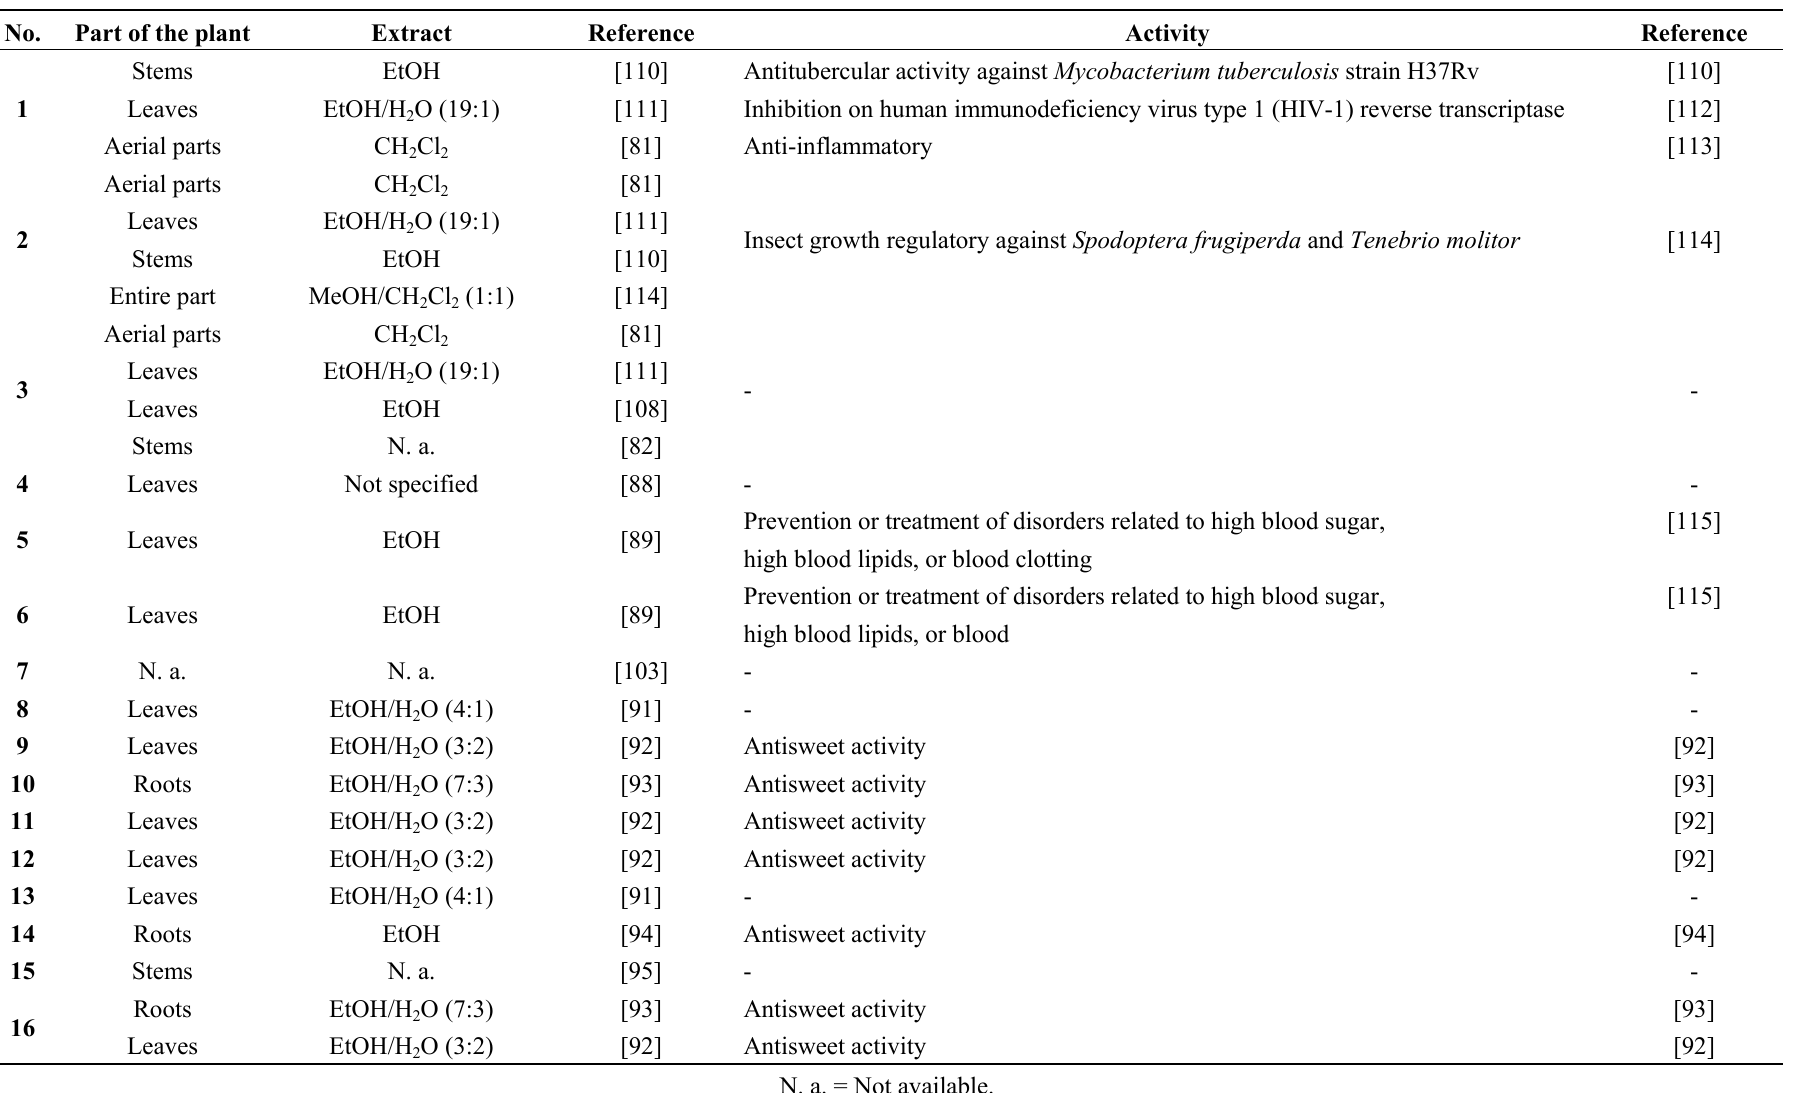
Table 8. Biological activity of compounds 1 – 16 and their natural